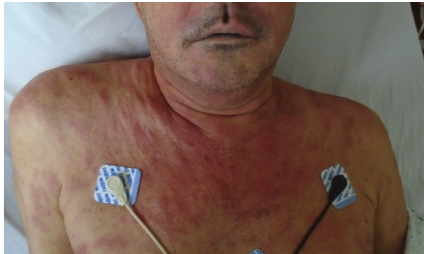
Figure 1: Picture of the patient taken on day of admission showing upper lip edema and diffuse, elevated, blanching, red-violaceous confluent lesions over the face, neck, and anterior chest.